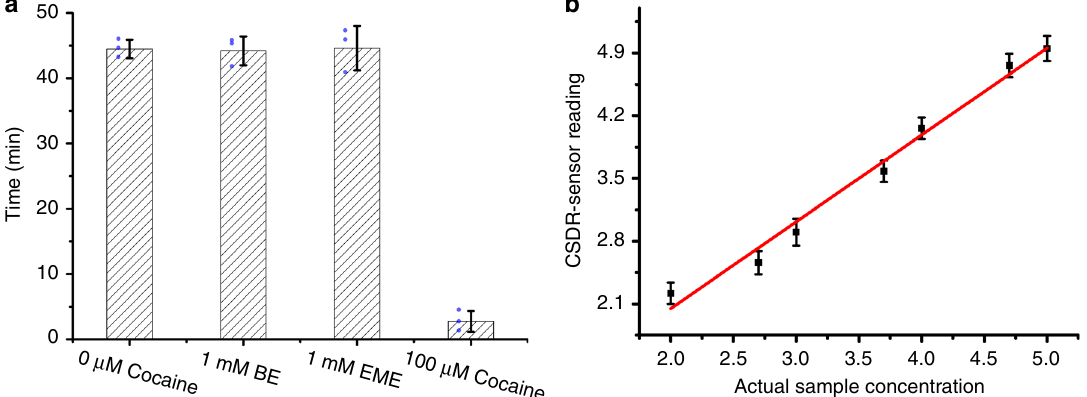
Fig. 6 Selectivity and practicality of the CSDR-Sensor. a Selectivity of the CSDR system with cocaine, benzoylecgonine (BE), and ecgonine methyl ester (EME). b Linear standard curves of cocaine detection in urine are obtained from 10 nM to 100 µ M in an 8 cm distance in a capillary tube. Each data point is an average of three replicates ( N = 3), and the error bars indicate the standard